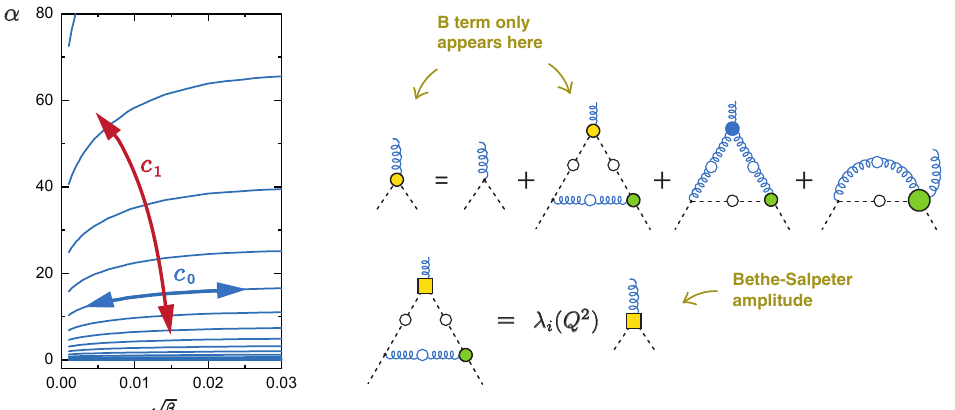
Figure 5: Left: Lines of constant physics in the ( α , β ) plane [ 5 ] . Right: DSE for the ghost-gluon vertex, which becomes a homogeneous BSE for the longitudinal B